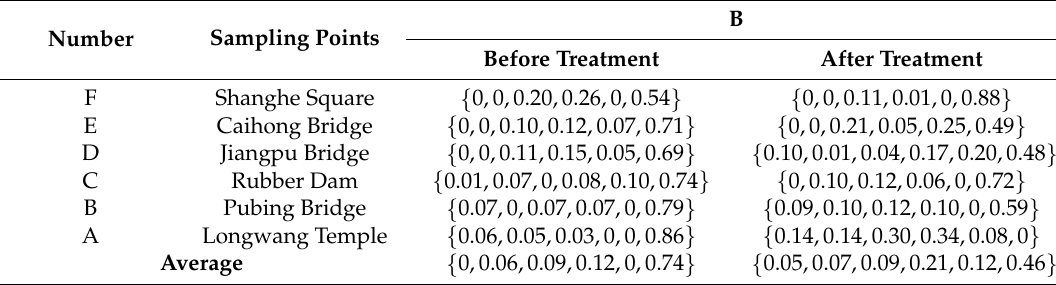
Table 12. The degree of membership before and after